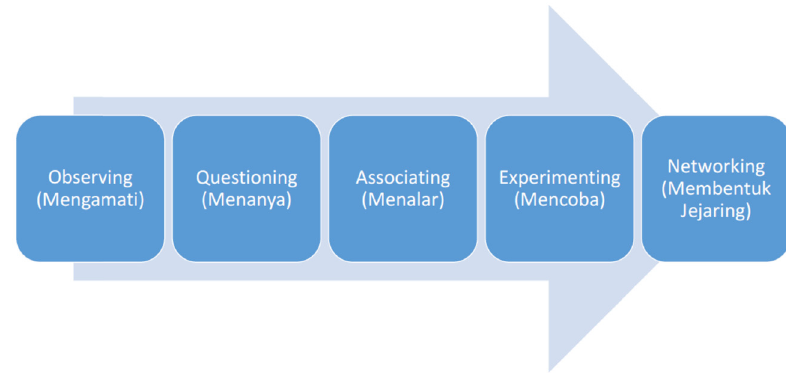
Figure 2: Scienti fi c learning